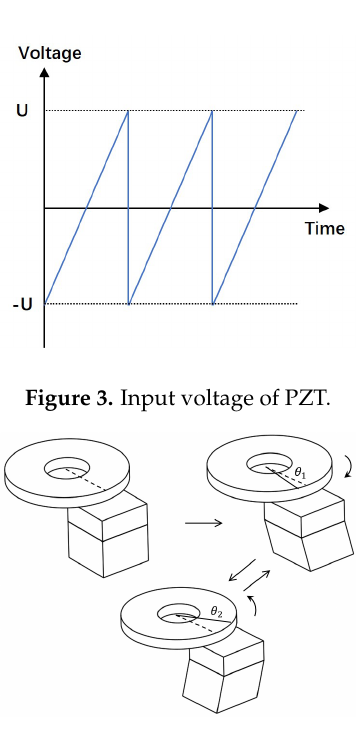
Figure 4. Working principle of the proposed micro-actuator.